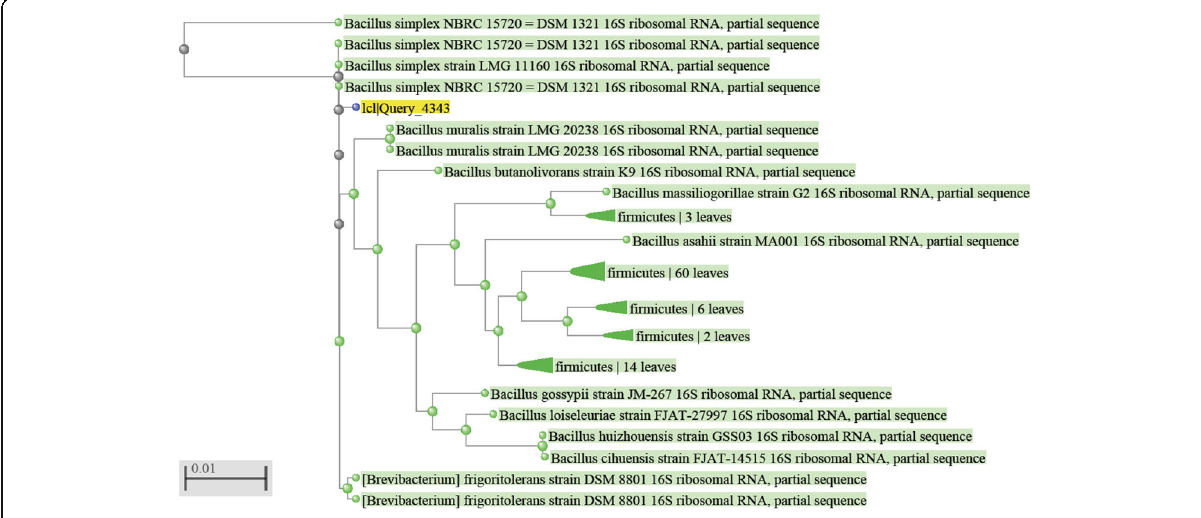
Fig. 10 The phylogenetic tree of the microorganism (NCBI